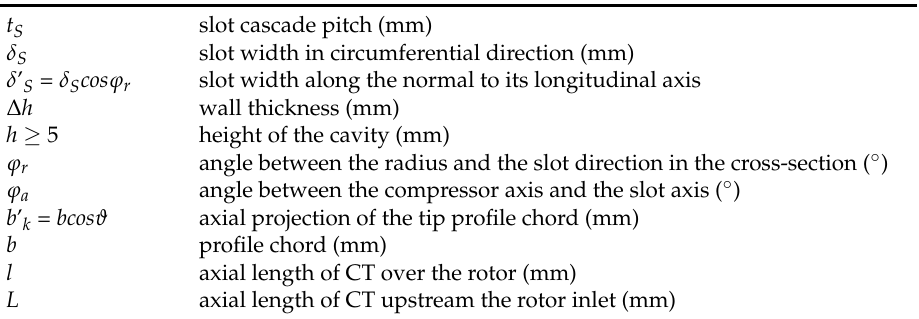
Figure 30. The casing treatment (schematic diagram).